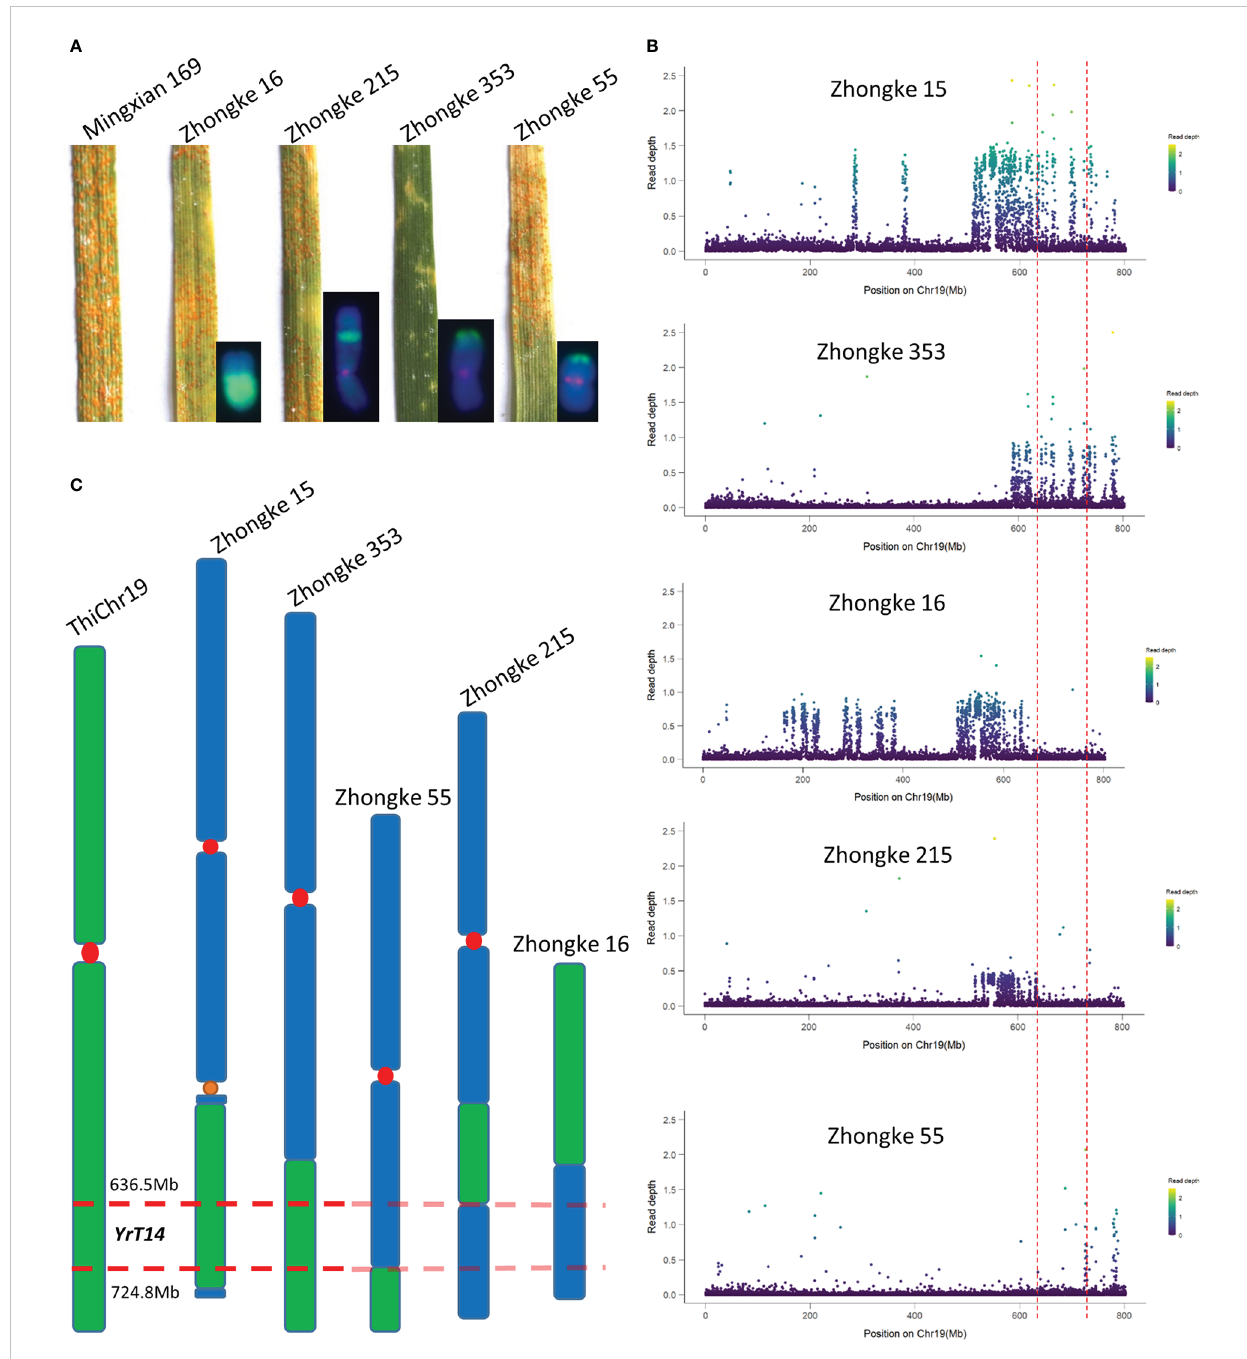
FIGURE 7 The physical mapping of the stripe rust resistance gene YrT14 . (A) Stripe rust resistance evaluation on the wheat – Th. intermedium translocation lines Zhongke 16, Zhongke 215, Zhongke 353 and Zhongke 55. (B) Genome resequencing and the read depth analysis on Zhongke 15, Zhongke 353, Zhongke 16, Zhongke 215, and Zhongke 55. (C) Mapping YrT14 by relying on the overlaps among different wheat – Th. intermedium